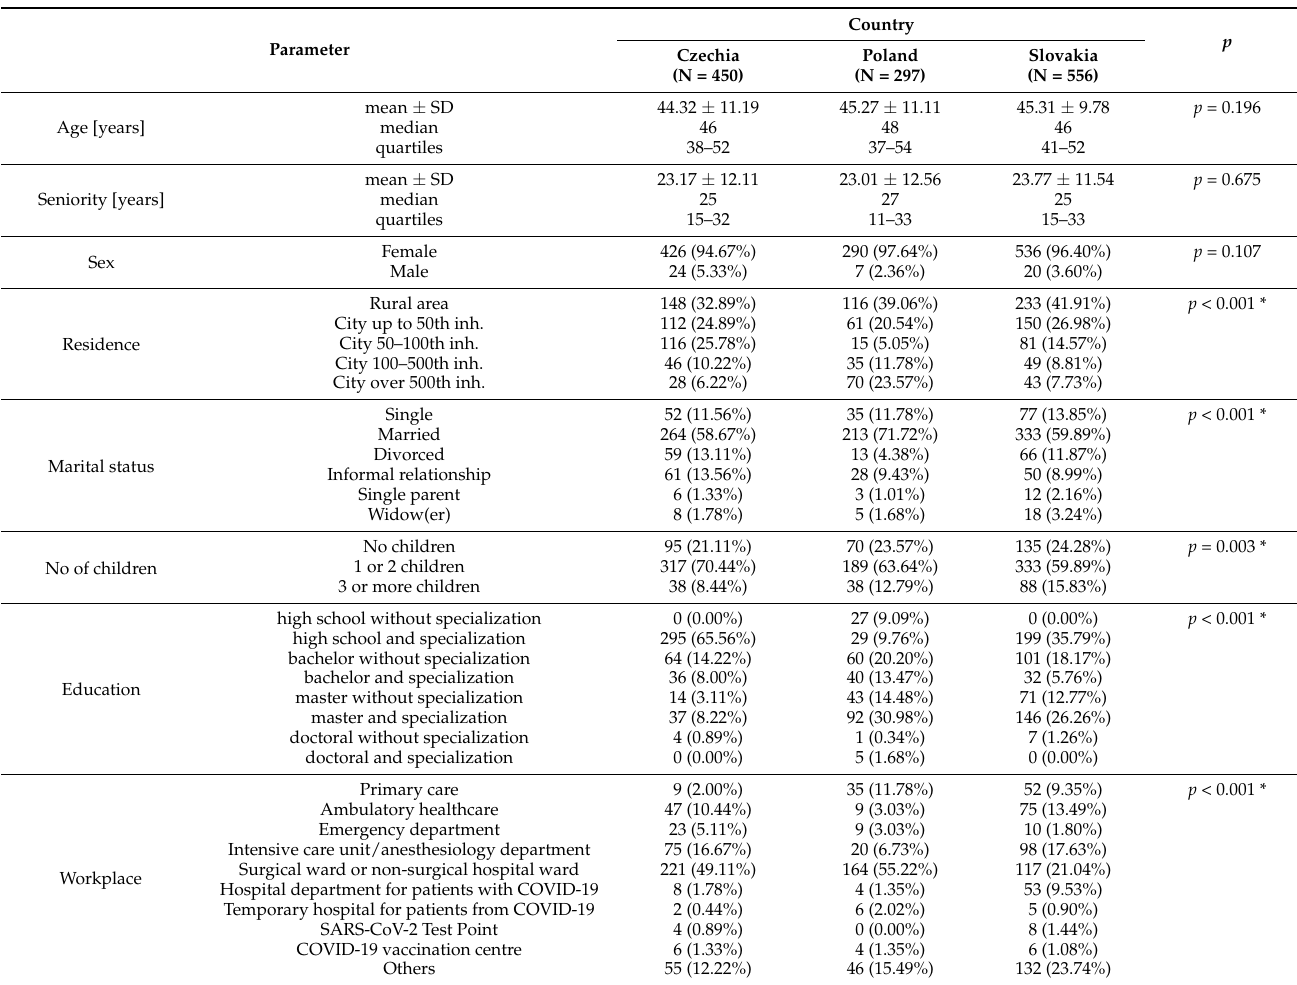
Table 1. Characteristics of the studied group of